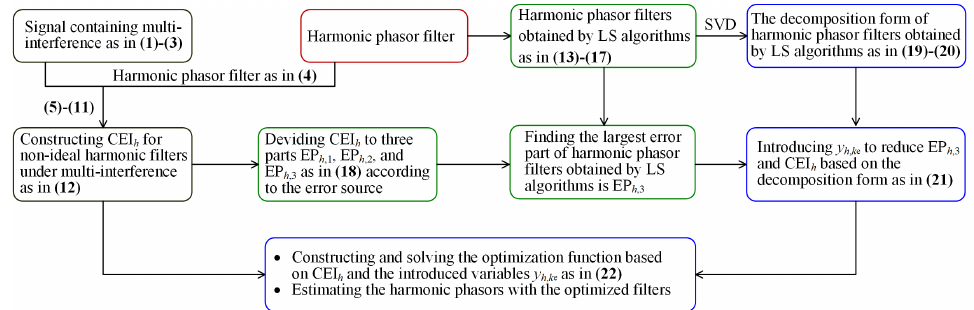
Figure 5. The diagram of the proposed optimal algorithm for dynamic harmonic phasor